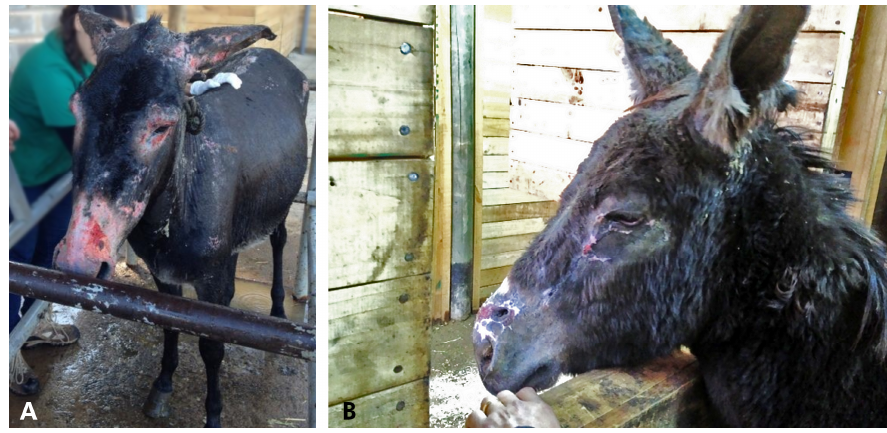
Figure 5. Appearance of burned skin in donkeys 3 ( A ) and 4 ( B ), 5 days after the fire.